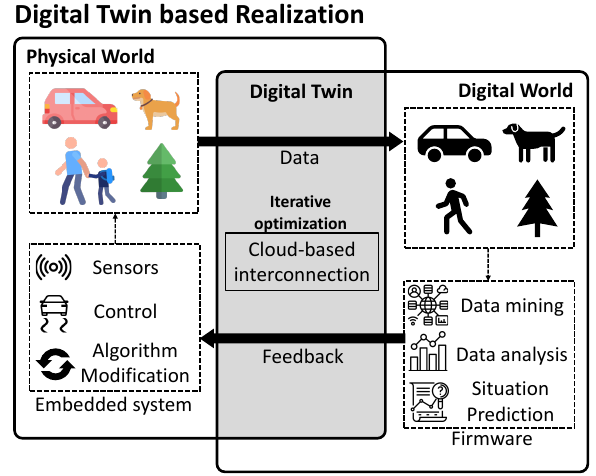
Figure 11. Schematic of digital twin based